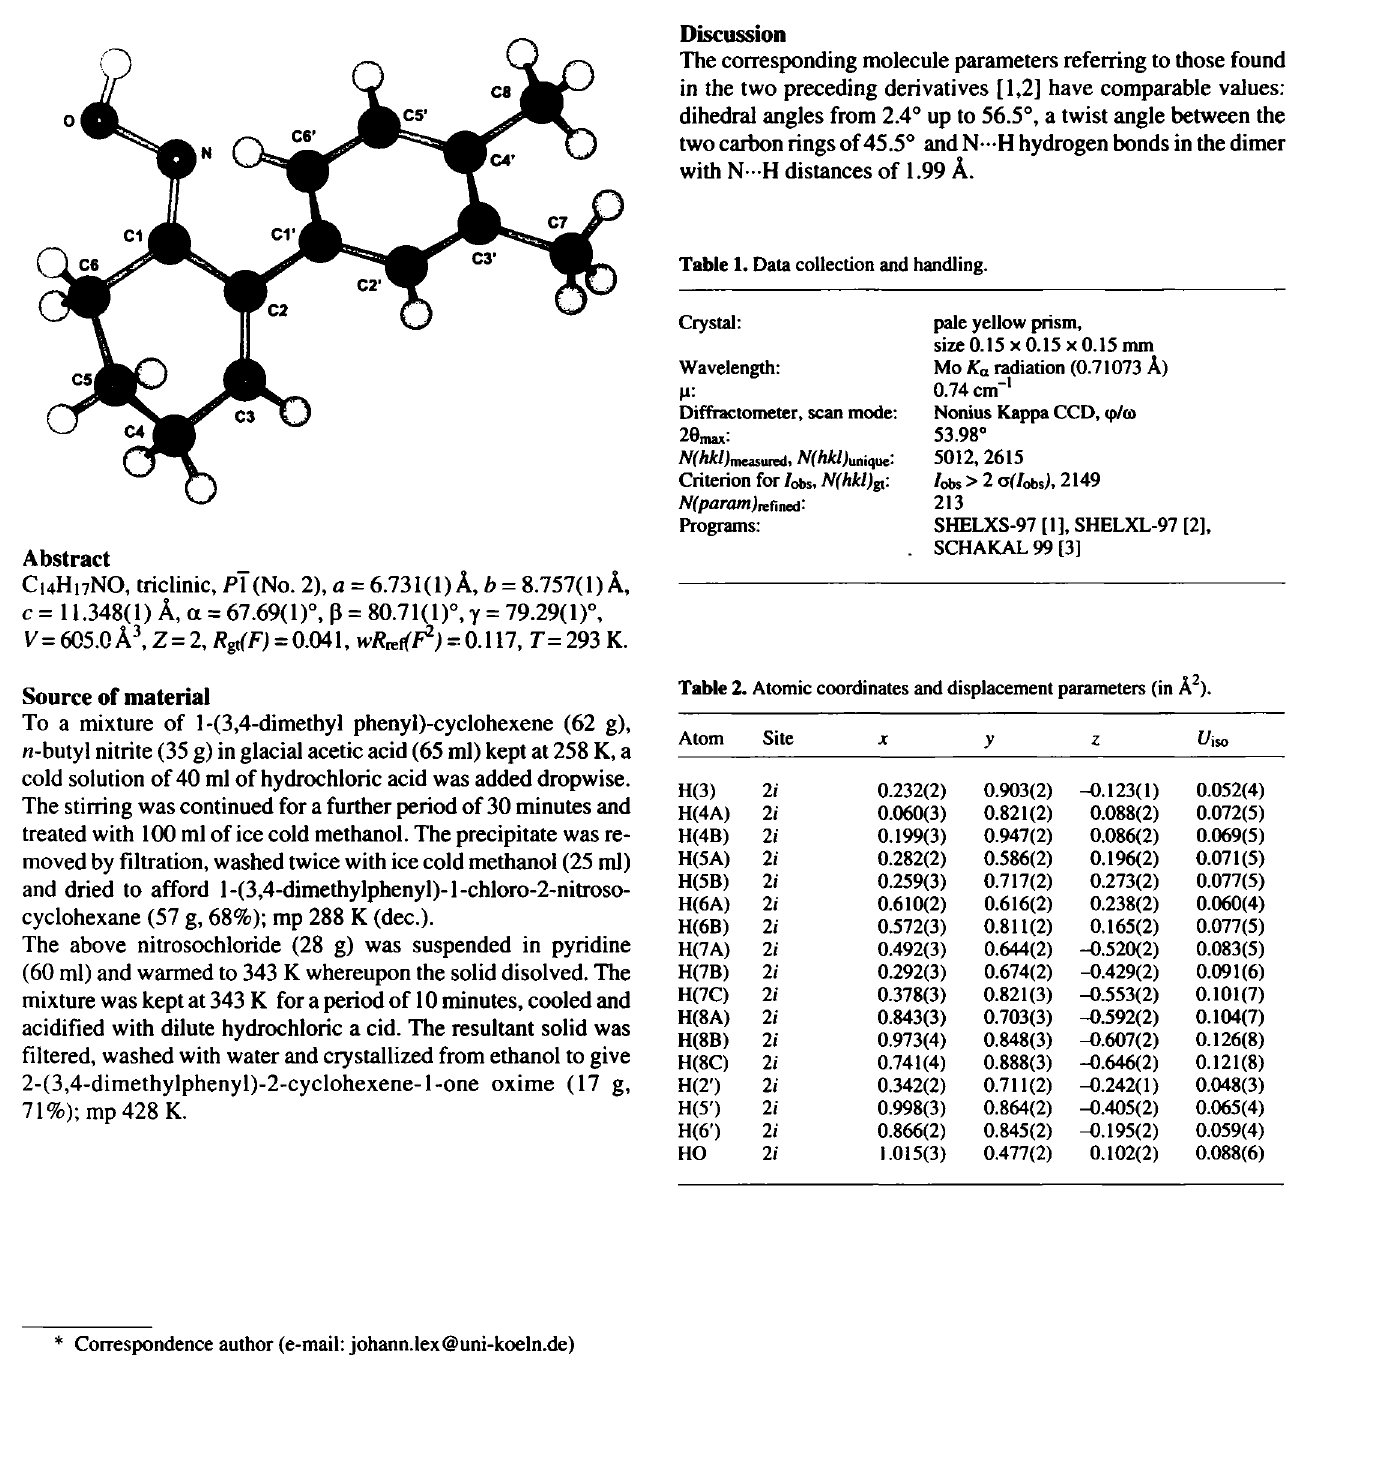
Table 1. Data collection and handling.